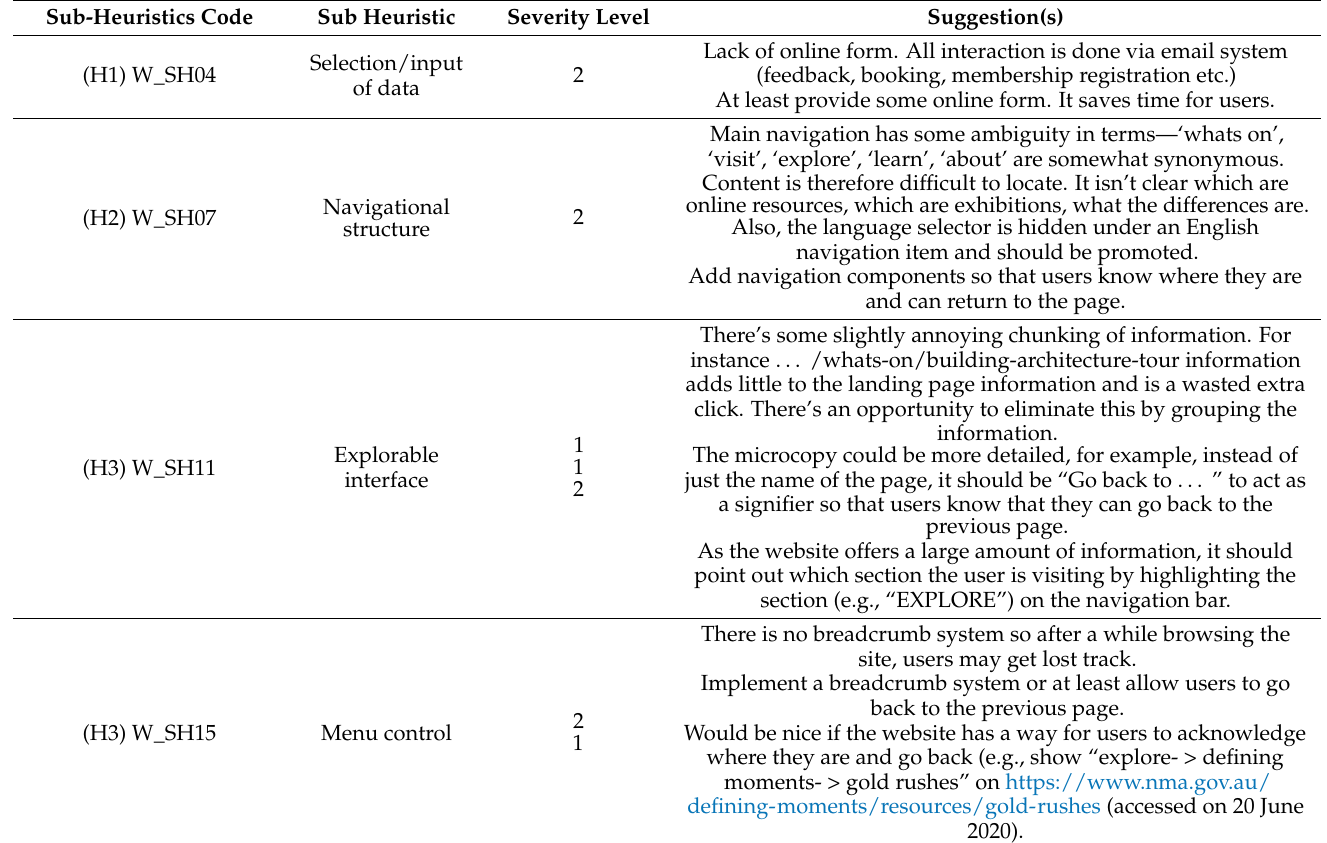
Table A10. UX Experts’ Suggestions for the NMA’s